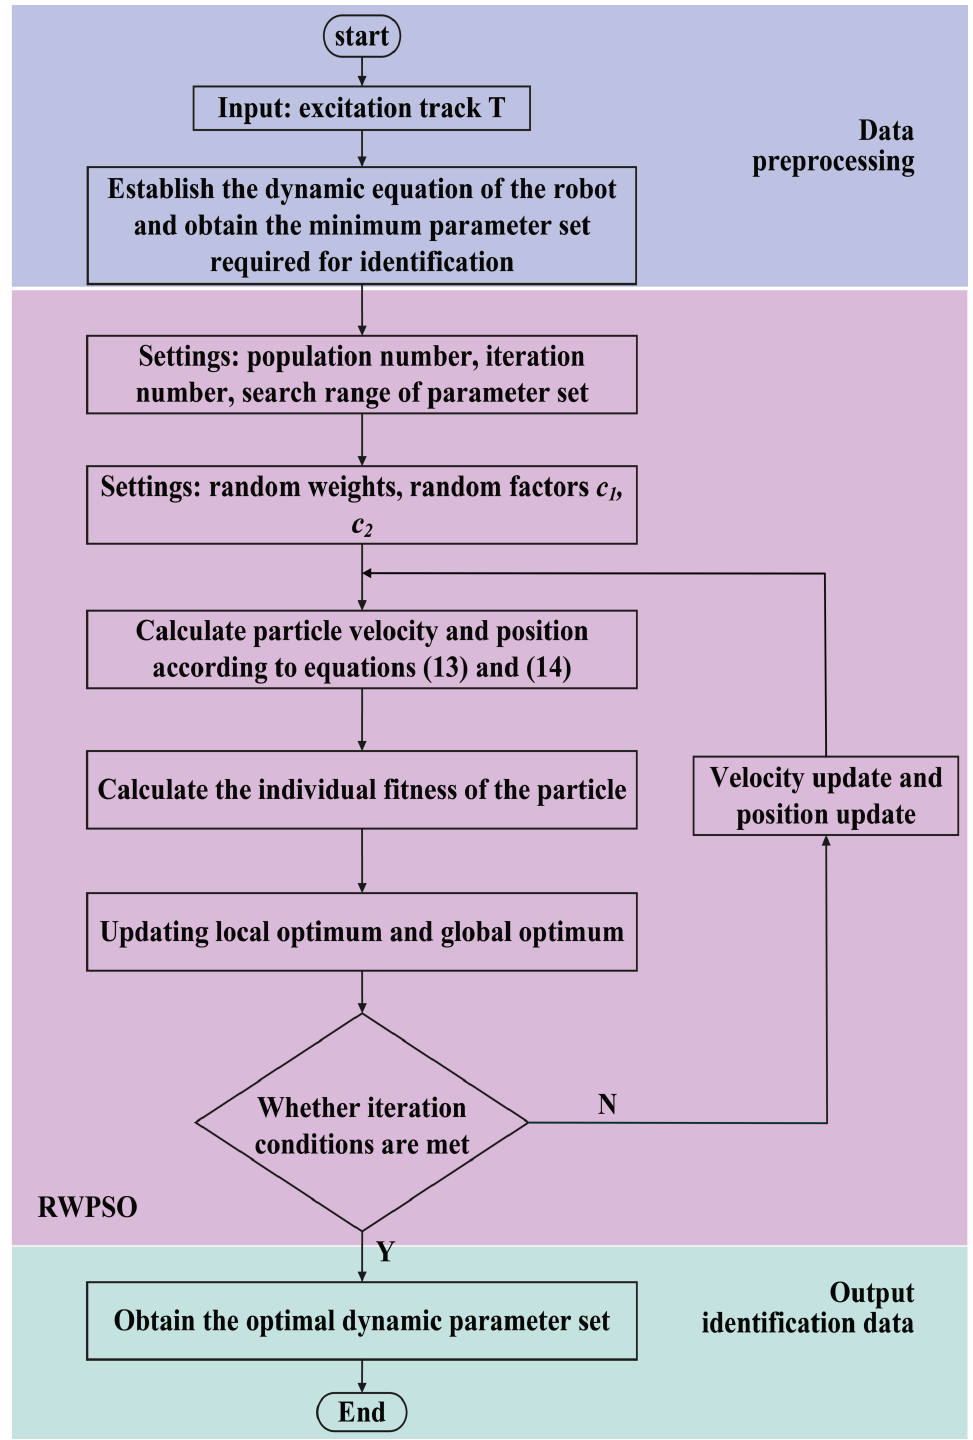
Figure 1. RWPSO identification flow